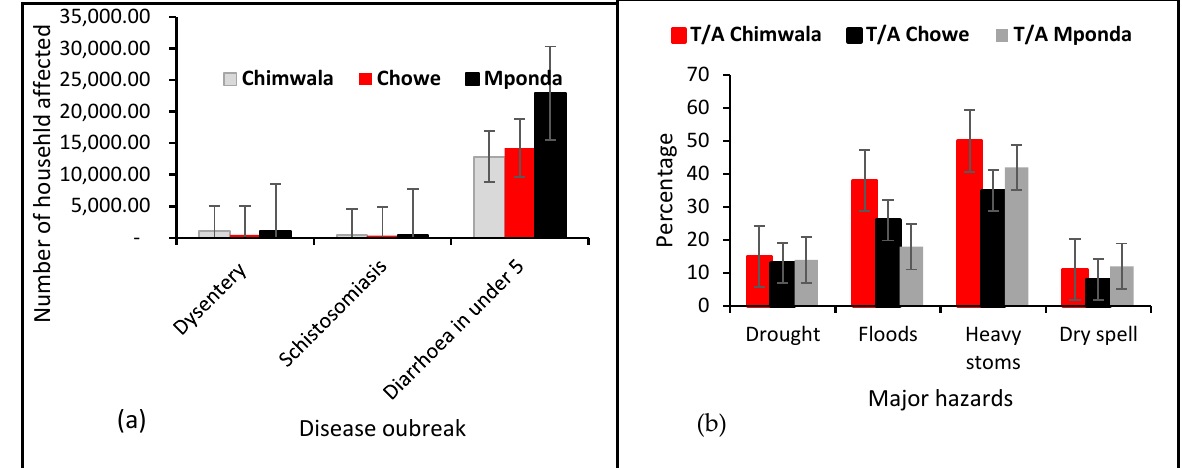
Figure 12. Lake Malombe disease outbreak and significant hazards. ( a ) Disease oubreak. ( b ) Major Figure 12- Lake Malombe disease outbreak and significant hazards.